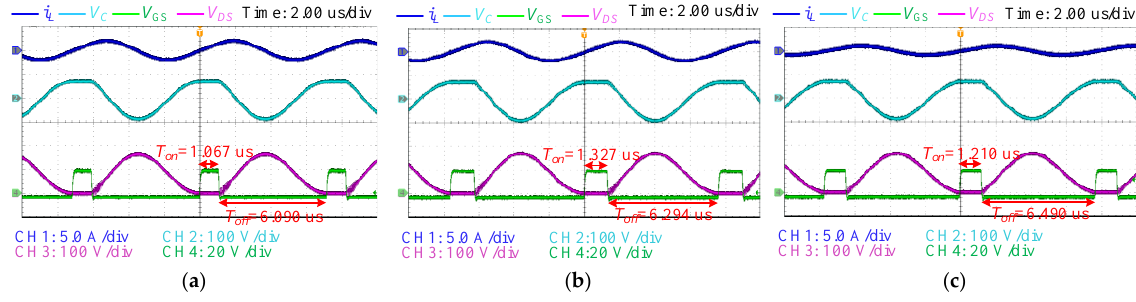
Figure 10. Experimental results to compare the ZVS behaviors under different load resistances: ( a ) R L = 20 Ω; ( b ) R L = 43 Ω; ( c ) R L = 80 Ω.